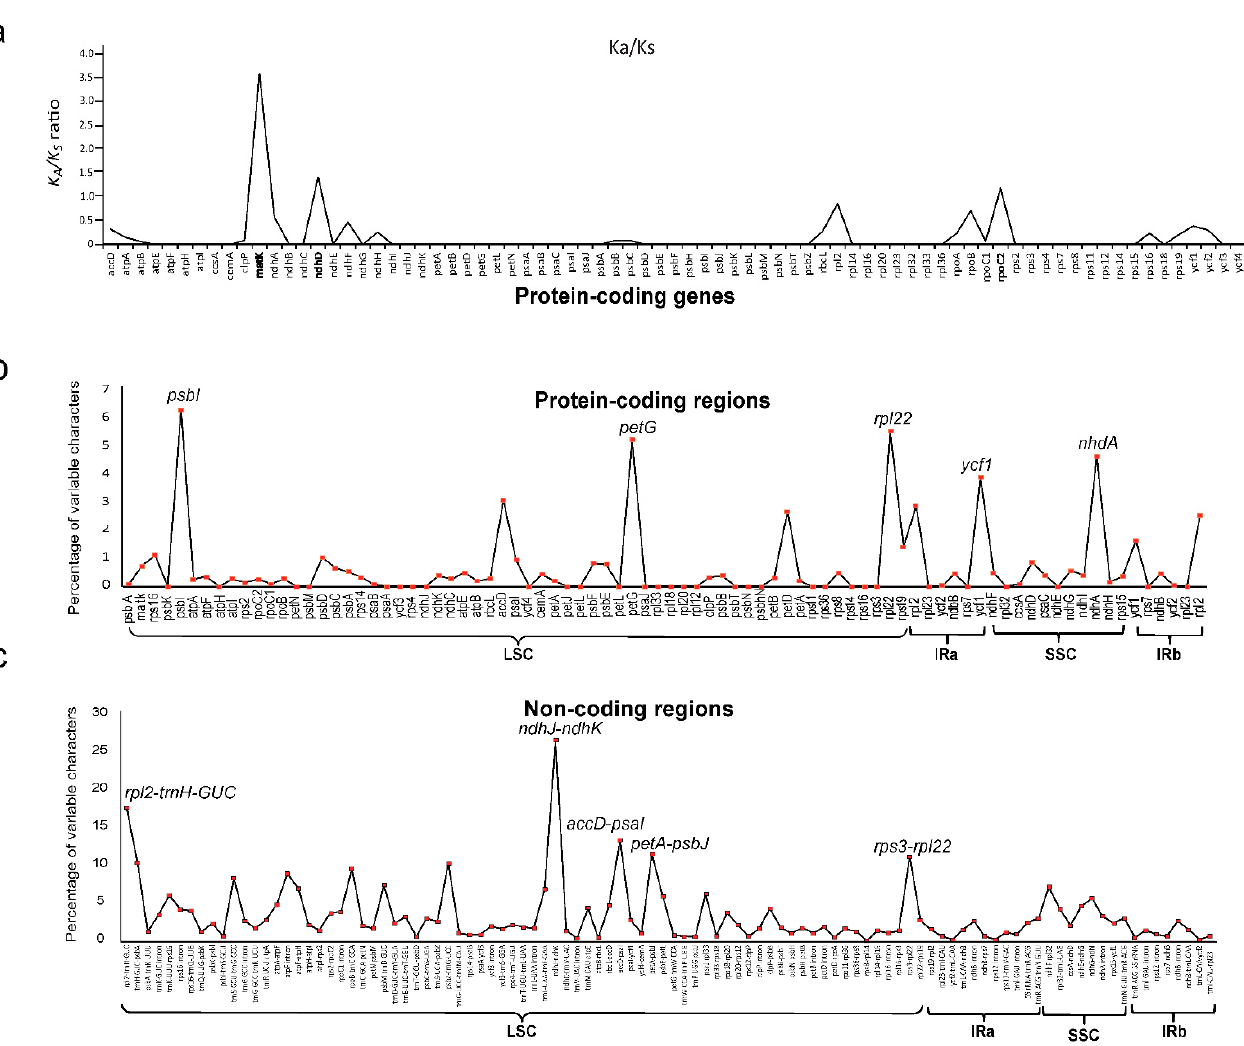
Figure 4. ( a ) The K A /K S ratio of 81 chloroplast genes shared by Castanea species. ( b , c ) Visualization of pairwise alignment of complete cp DNA sequences of each of seven genotypes with C. mollissima 1 (reference genome). VISTA-based similarity plots portraying the sequence identity of the four Castanea species with the reference C. mollissima are shown. The annotation of protein-encoding genes is provided for C. mollissima on top (based on the C. mollissima Shaanxi data).